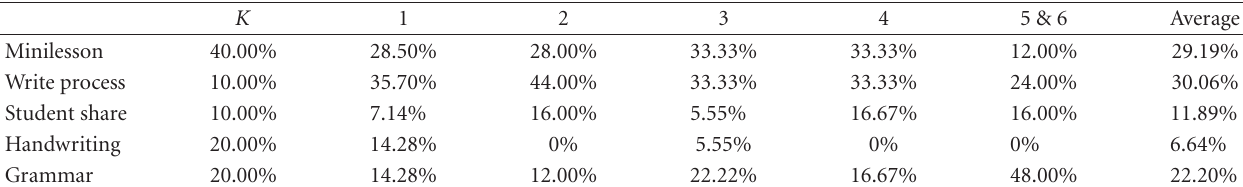
Table 2: Frequency of observed writing components.